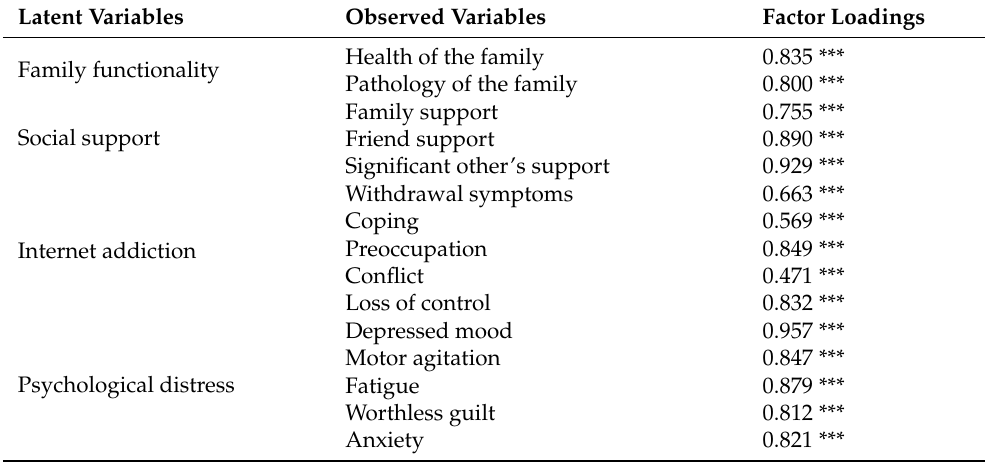
Table 2. Results of measurement